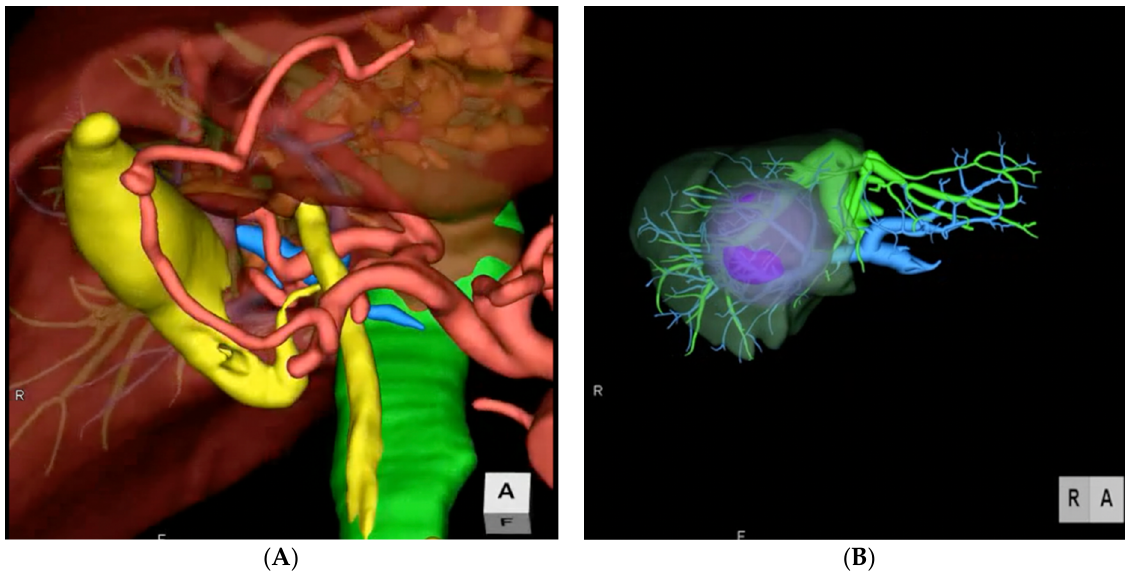
Figure 1. Two examples of preoperative 3D imaging. ( A ) Reconstruction of arterial, portal, and venous system and biliary tree. ( B ) Reconstruction of vascular structures, portal territories and tumor.